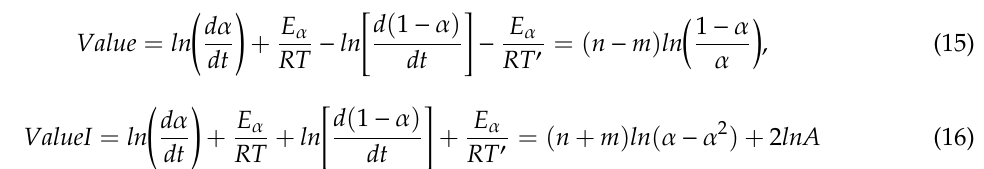
Figure 11. Plots of ValueII calculated using DSC data for ( a ) neat epoxy, ( b ) epoxy/P-HNT, ( c ) epoxy/A-HNT and ( d ) epoxy/F-HNT.